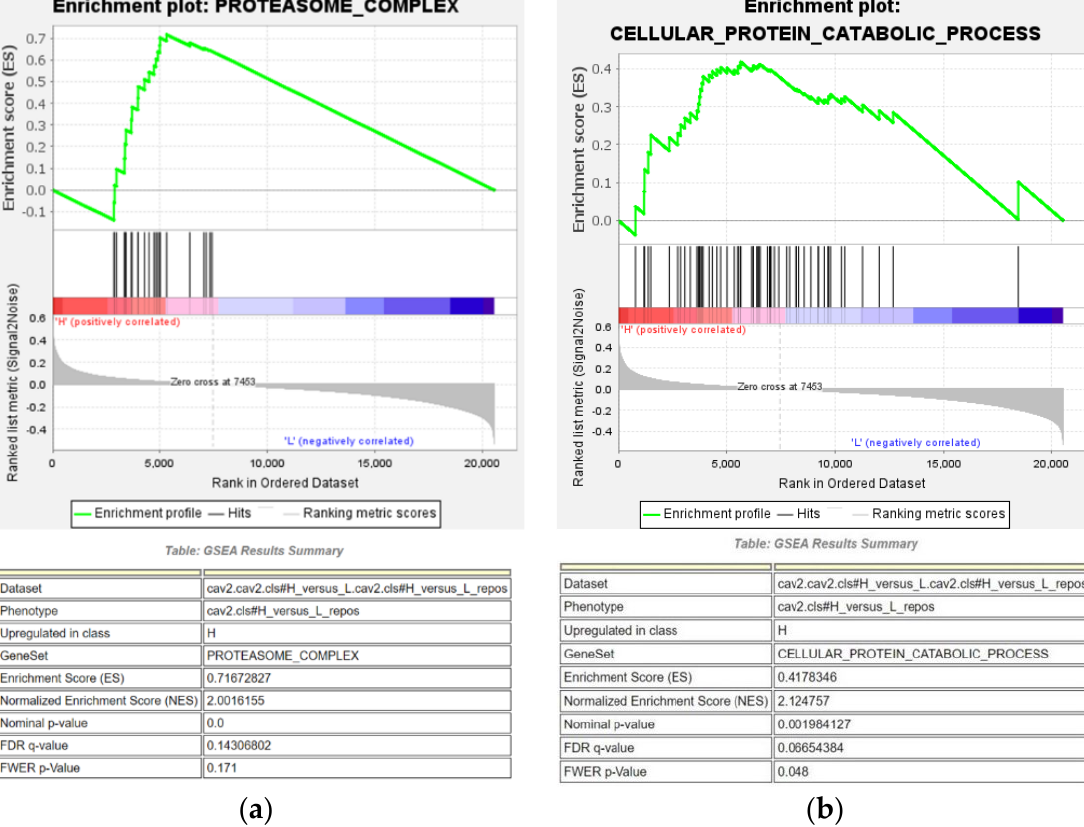
Figure 8. Cellular protein catabolic process ( a ) and proteasome complex ( b ) are significantly enriched in the CAV2 high expression subgroup ( p -value < 0.02, FDR q -value < 25%), thereby providing a feasible hypothesis for particular signal pathways involved in our target